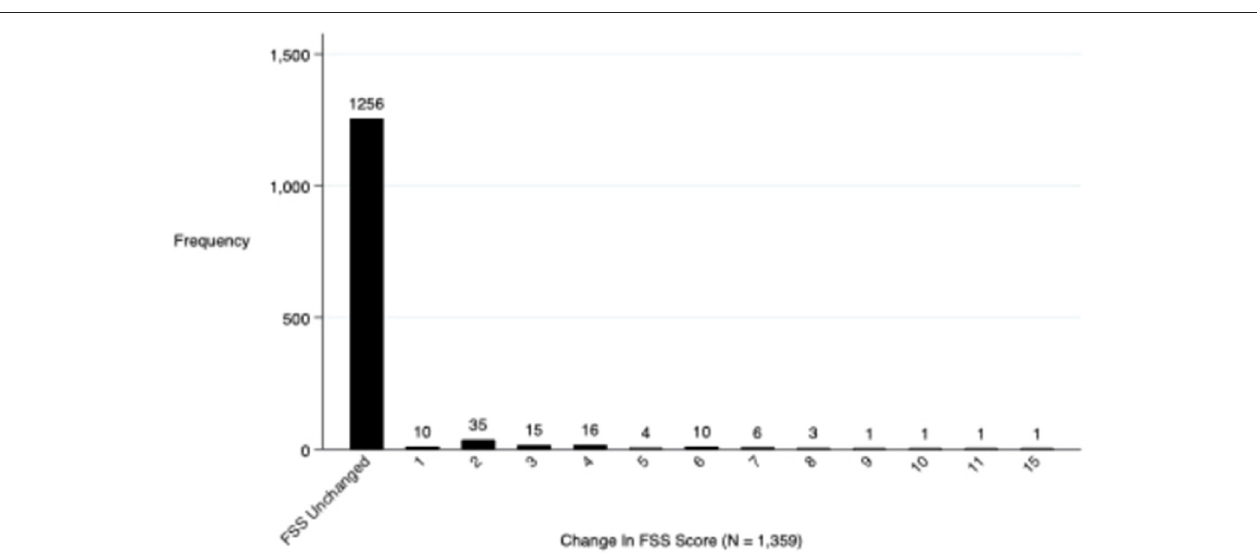
FIGURE 3 | Frequency of changes in subject’s FSS scores between baseline and 28-day follow-up.